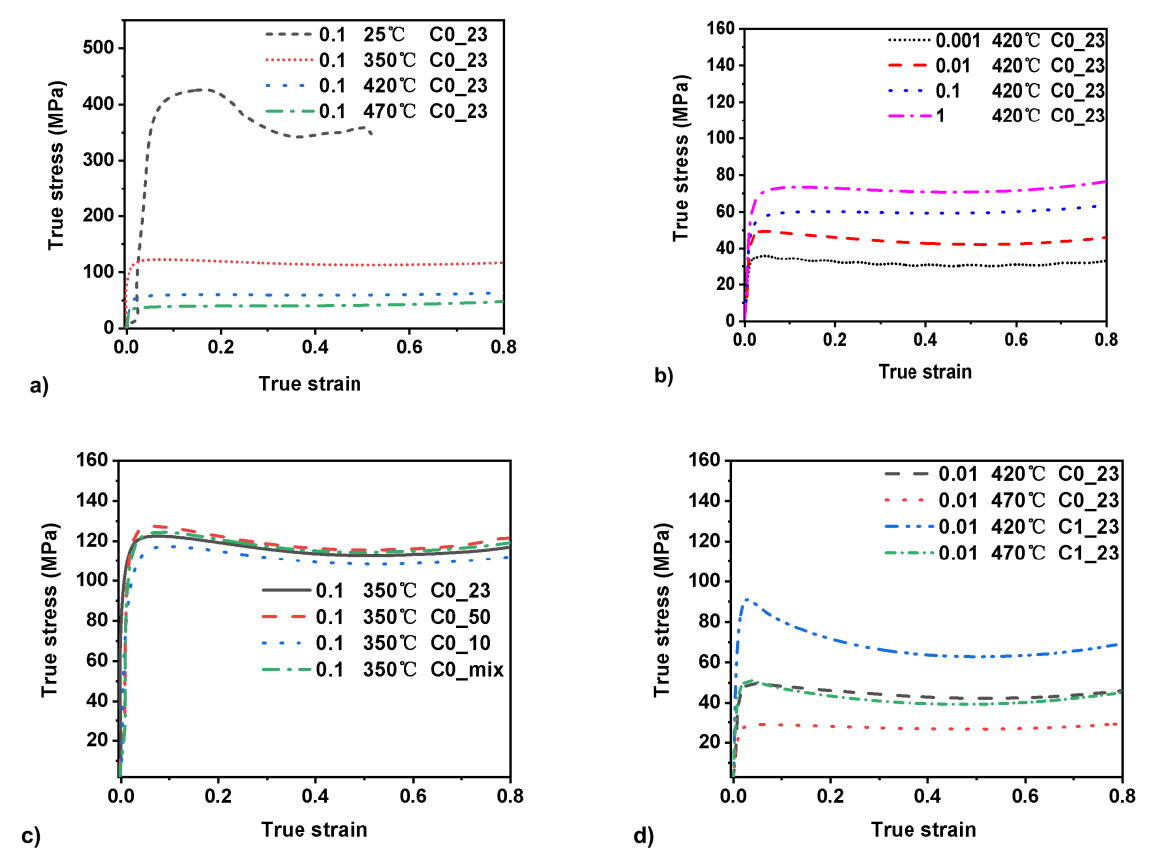
Figure 2. Compression curves: ( a ) material C0_23, the effect of the temperature at same strain rate; ( b ) material C0_23, the effect of strain rate at the same temperature; ( c ) constant temperature and strain rate, the effect of varying fraction; ( d ) materials C0_23 and C1_23 at constant strain rate, comparison at two